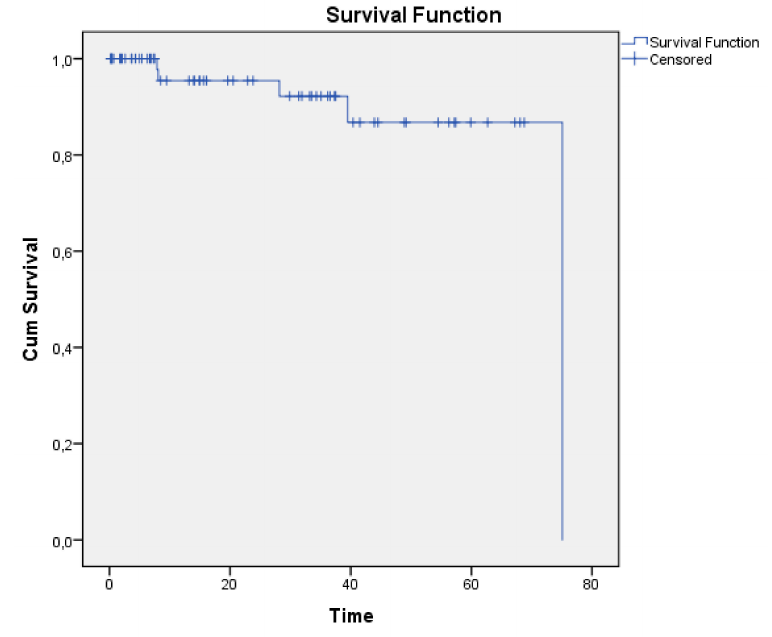
Figure 1. Kaplan–Meier implant survival graph for medical complications. Time; time in